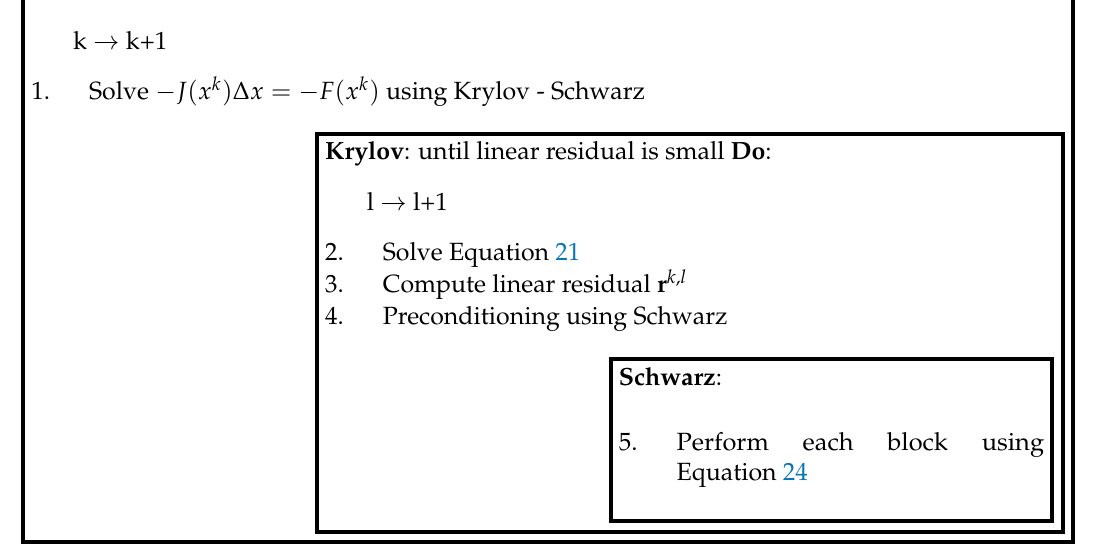
Figure 2. Newton–Krylov–Schwarz